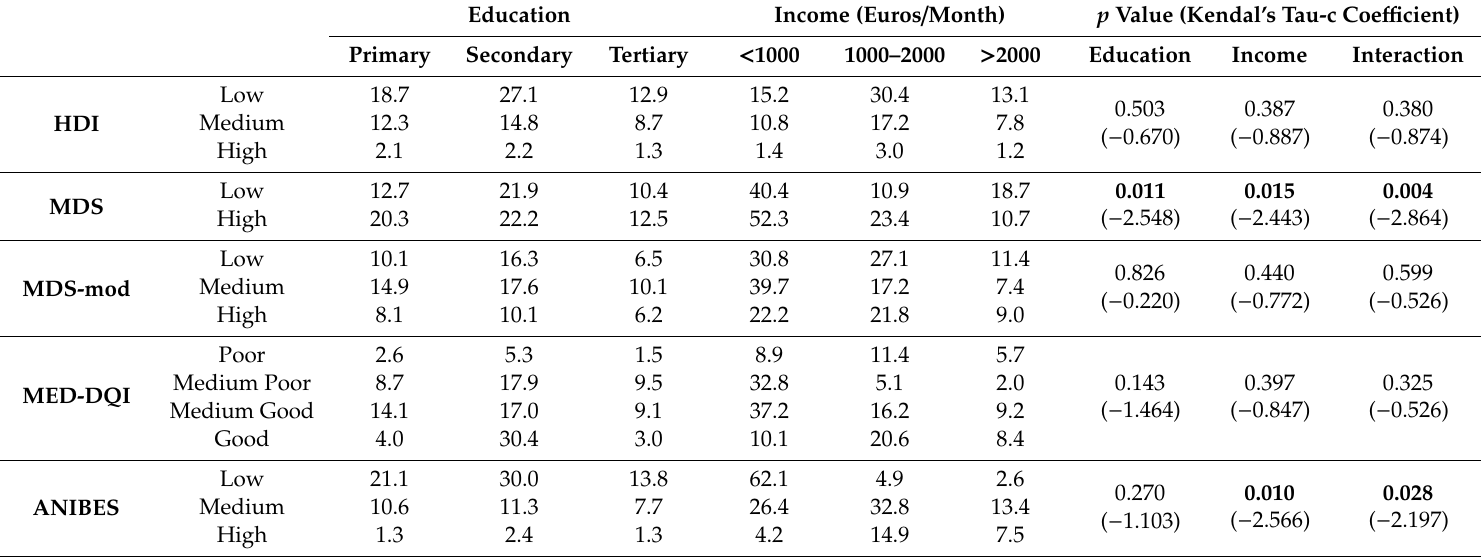
Table 5. Percentages of the ANIBES population and associations of education and income levels and their interactions with the degree of diet quality for each diet quality